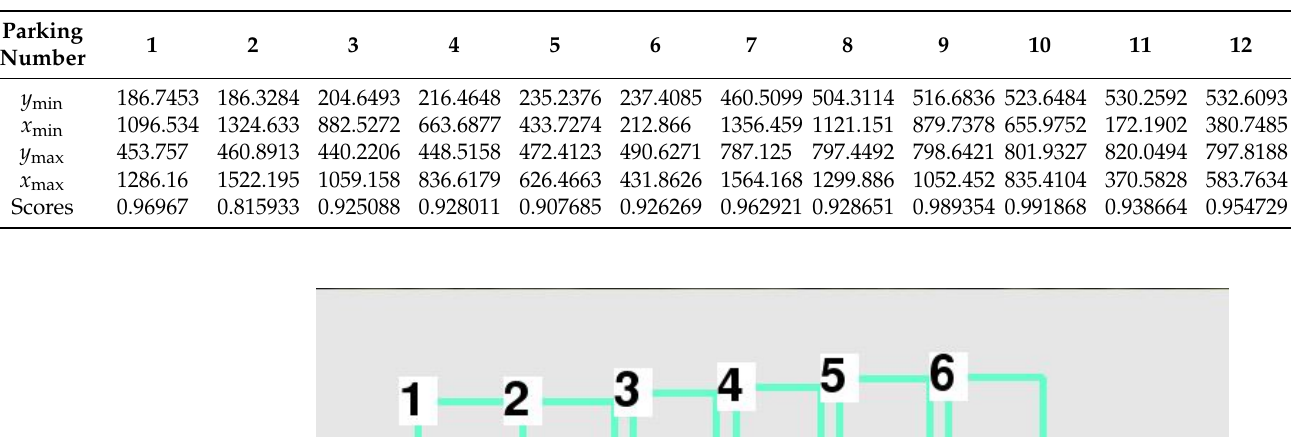
Table 5. Position of the vehicles after sorting and the numbering of the parking spaces by the Timsort algorithm.